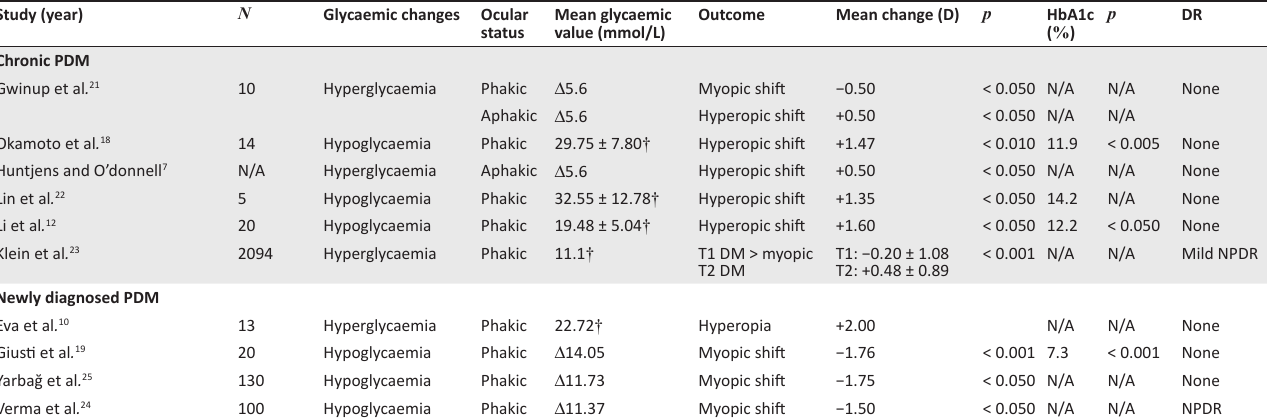
TABLE 1: Effect of glycaemic changes on refraction or refractive error in people with diabetes mellitus. Study (year)